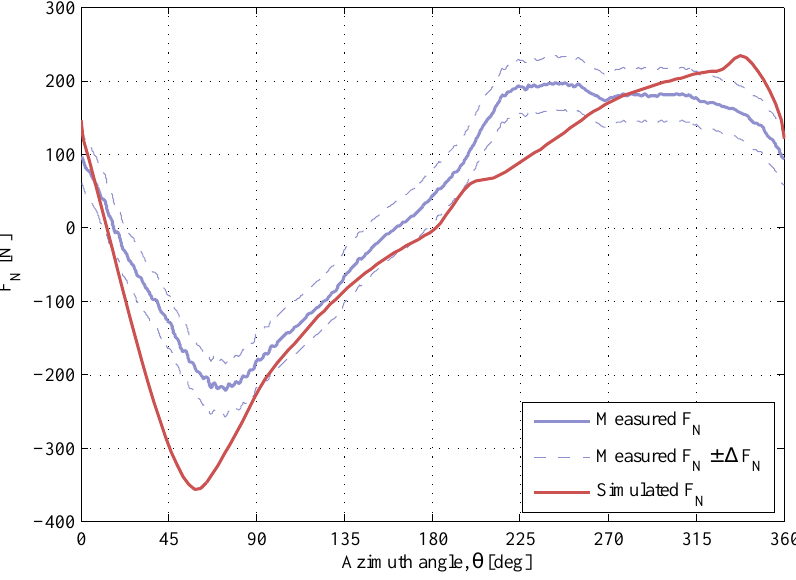
Figure 10. The normal force at λ = 2 . 26 , Ω = 45 . 19 rpm . The air density and the kinematic viscosity are ρ = 1 . 25 kg / m 3 and ν = 1 . 42 · 10 − 5 m 2 / s